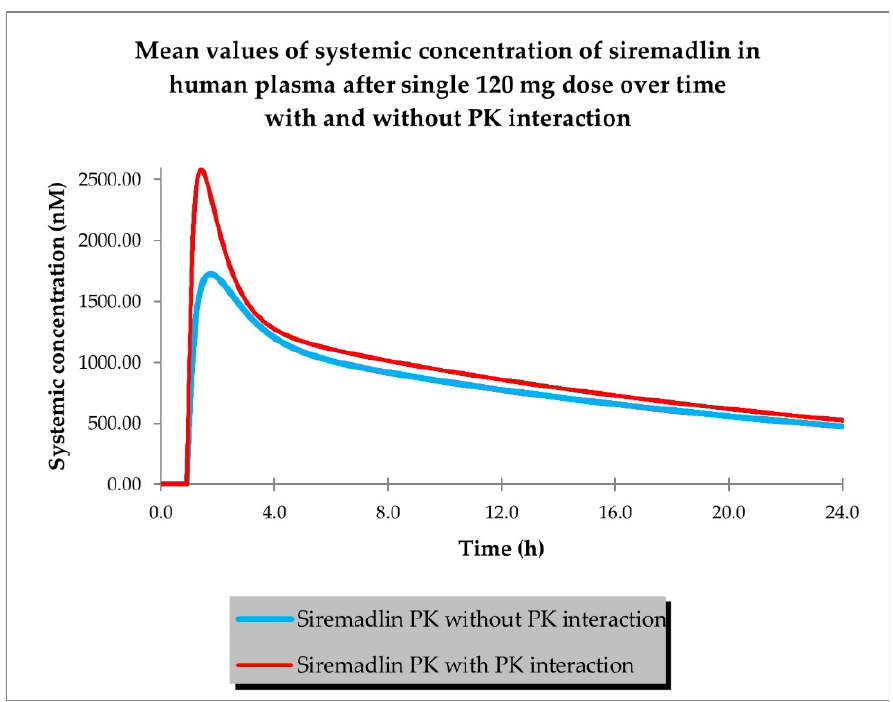
Figure 4. PBPK model of siremadlin with and without estimated PK interaction in cancer patient representative ( n = 1).